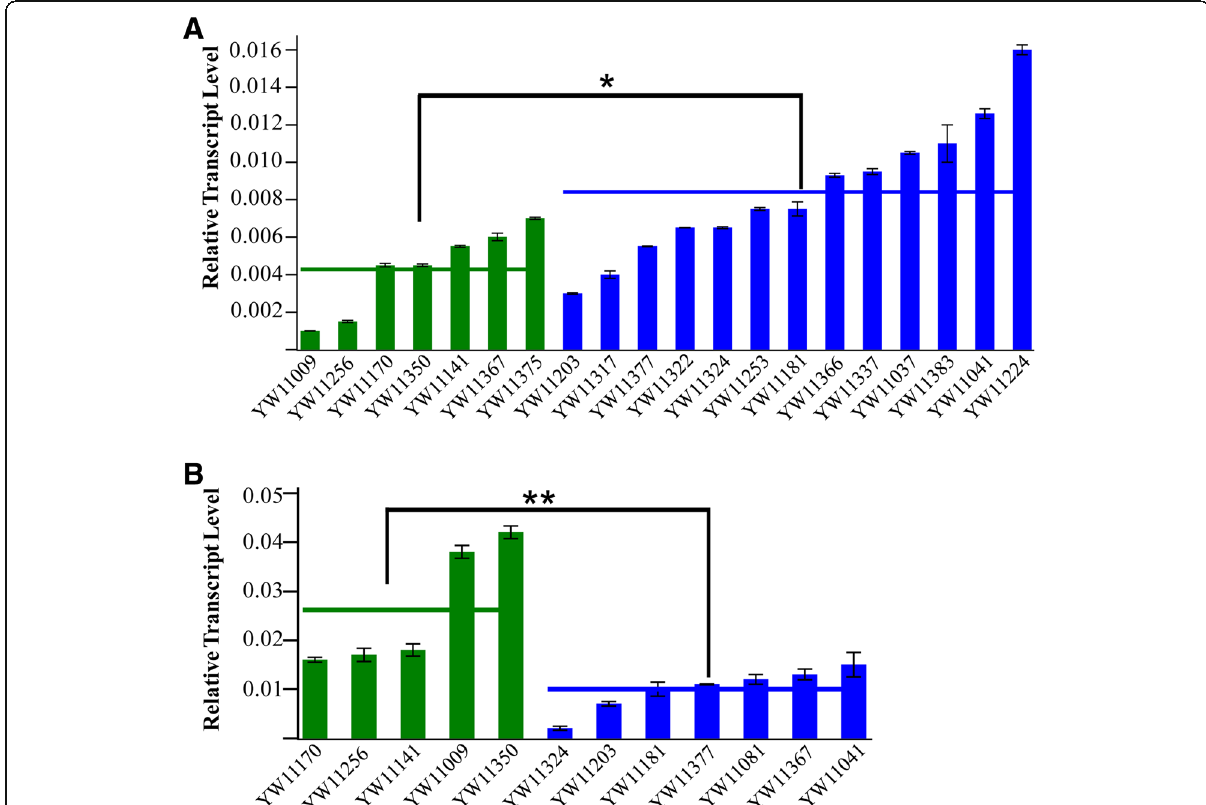
Fig. 6 qRT-PCR analysis of Os01g28690 ( a ) and Os05g32120 ( b ) between the extremely low and high TN accessions. X-axis represents the different rice accessions. Green bars are the low TN accession, and blue bars are the high TN accessions. Y-axis represents the relative gene transcript levels. The green and blue horizontal lines are the average gene expression levels in the low and high TN rice accessions, respectively. Black bars indicate the difference between the means of TNs in low and high TN accessions. ’ * ’ marks significant differences ( P = 0.0132), while ‘ ** ’ marks very significant differences ( P =